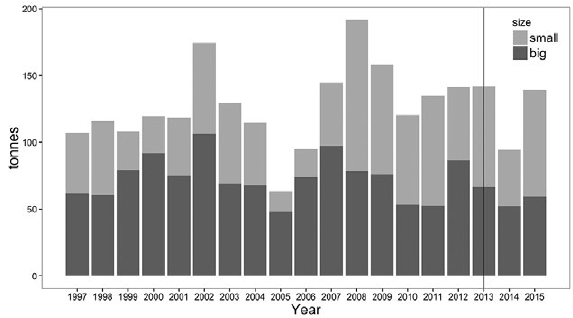
Fig. 1. – Red shrimp catches (tonnes) for the trawling fleet of Palamós shown per commercial size class: small individuals (<30 mm cephalothorax length) in light grey and medium/big individuals ( ≥ 30 mm cephalothorax length) in dark grey. The vertical line indi- cates the starting year of full implementation of the 40-mm square mesh codend, i.e. 2013. Previously, the 50-mm diamond mesh co- dend was used. Note that from 2008 onwards the proportion of small individuals in the catches was above 50% in almost all